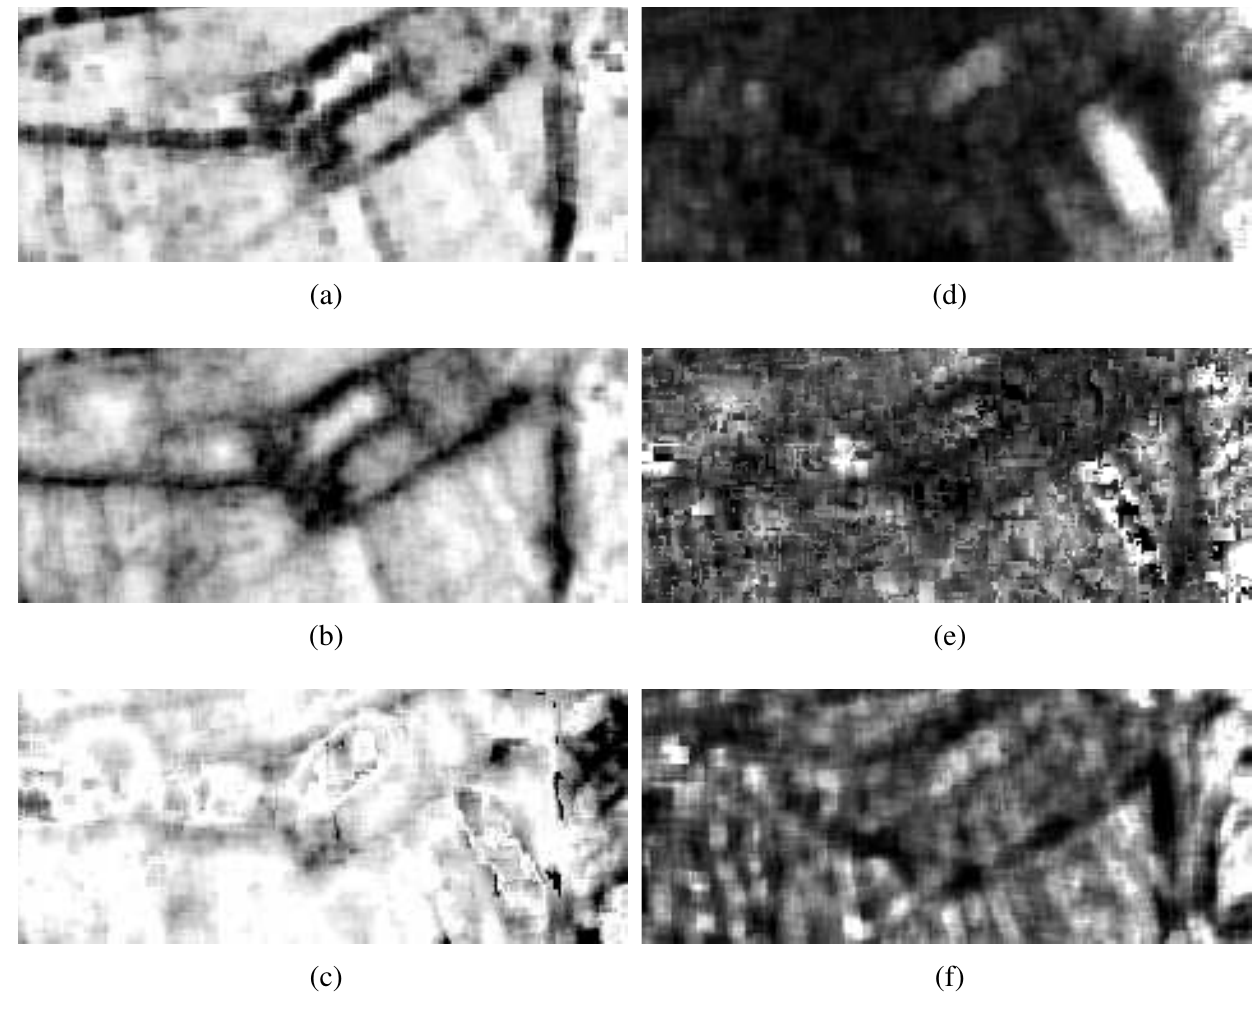
Figure 8. Similarity images of the panchromatic/SAR pair: (a) distance to independence; (b) mutual information; (c) CRA; (d) Woods criterion; (e) robust Woods criterion; (f) correlation